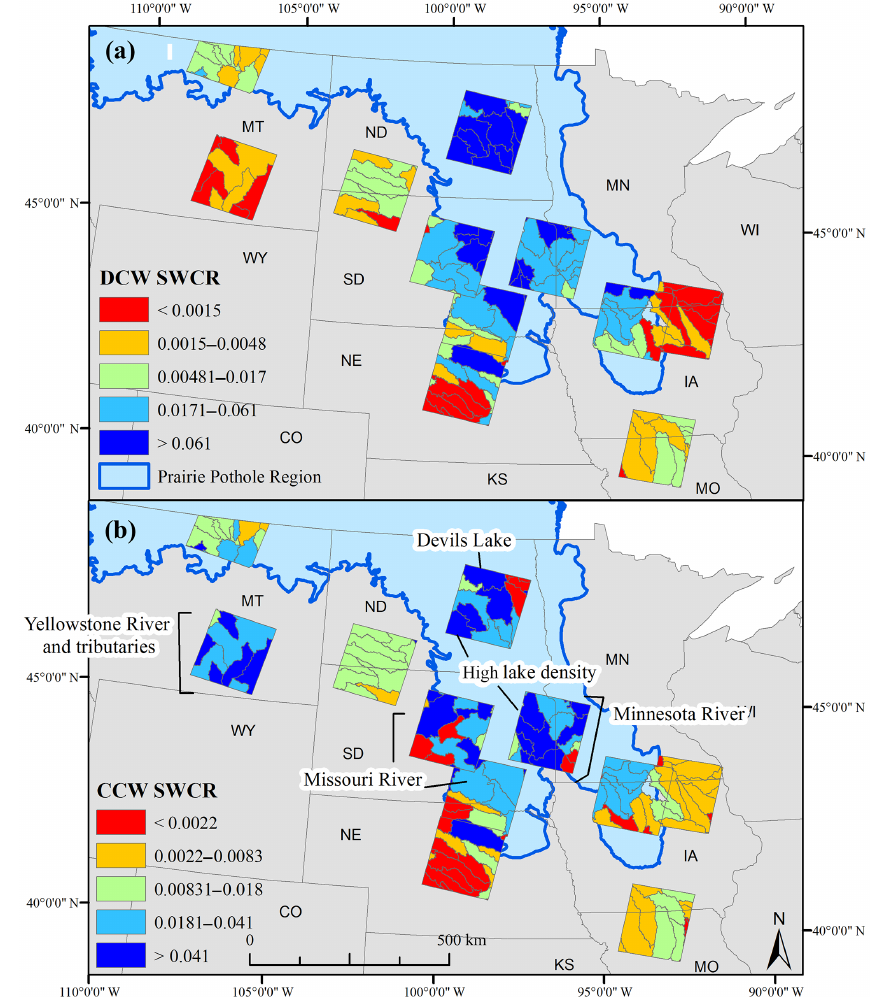
Figure 6. The spatial distribution of the Surface Water Climate Response (SWCR) values from the statistical relationships between avail- able water, defined as precipitation minus potential evapotranspiration accumulated over the previous nine months, and surface water extent. Greater SWCR values indicate greater change in surface water extent with increased available water. Surface water extent was divided be- tween (a) disconnected surface water (DCW), or surface water extent disconnected from the stream network, and (b) continuously connected water (CCW), or surface water extent connected to the stream